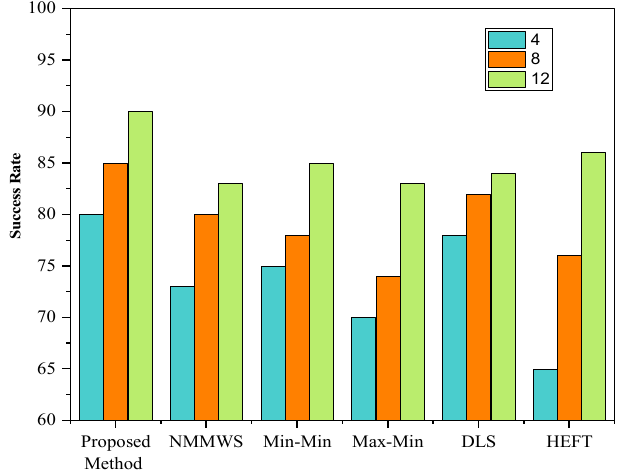
Figure 15. Success rate on the Cybershake workflow.